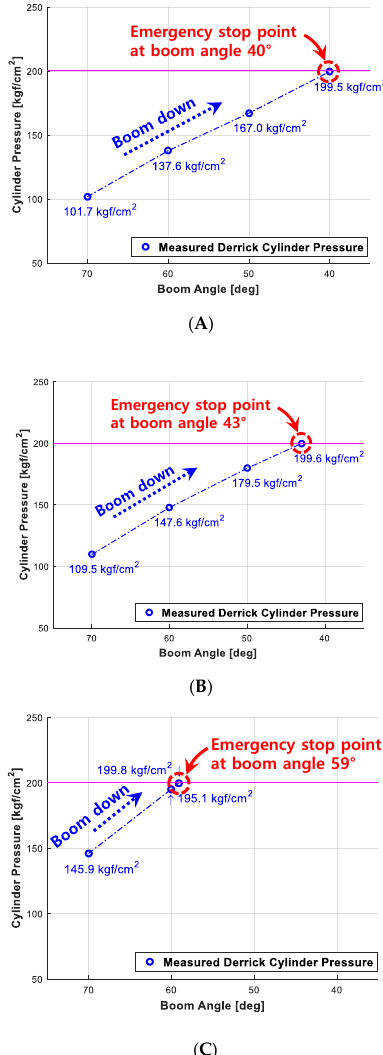
Figure 18. Experiment outputs (controlled boom angle and derrick cylinder pressure). ( A ) 390 (+110) kgf; ( B ) 500 (+110) kgf; ( C ) 1000 (+110) kgf.